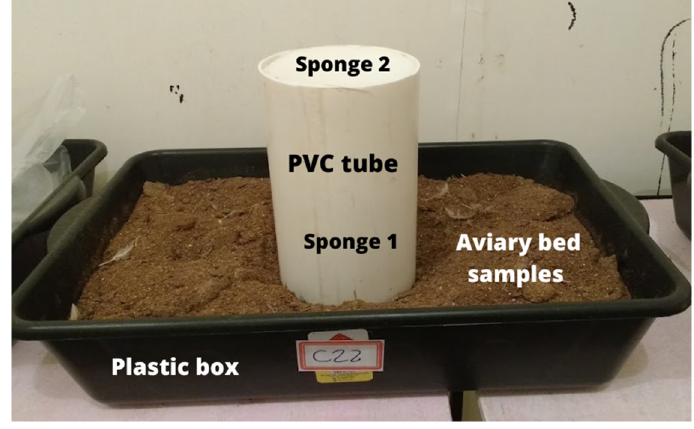
Figure 4. Image of the plastic box with the poultry litter sample and the volatilized ammonia capture device Saraz Method for Determination of Ammonia Emissions (SMDAE).